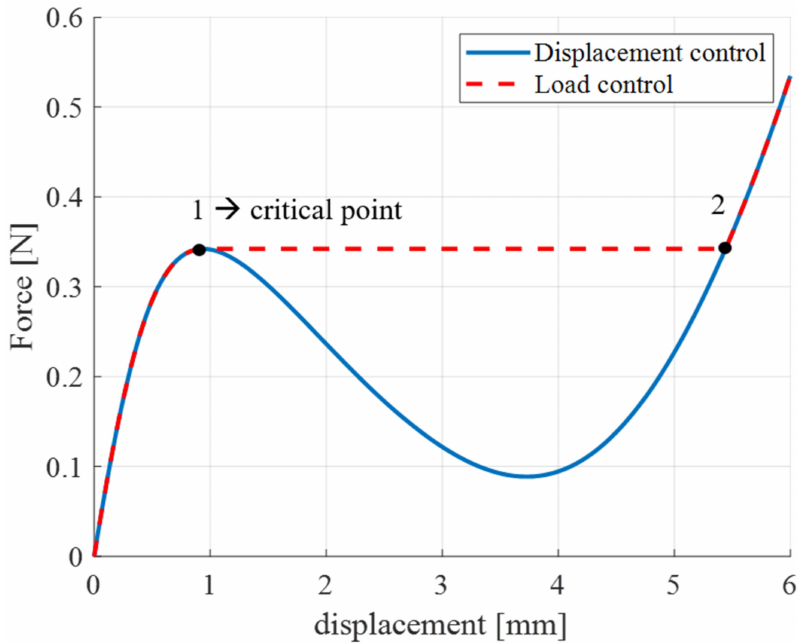
Figure 11. Experimental force–displacement curve of polymeric dome. The red and blue lines are derived by applying the load and displacement control methods, respectively. Points 1 and 2 indicate the dynamic jump occurring under load control mode, from state 1 to